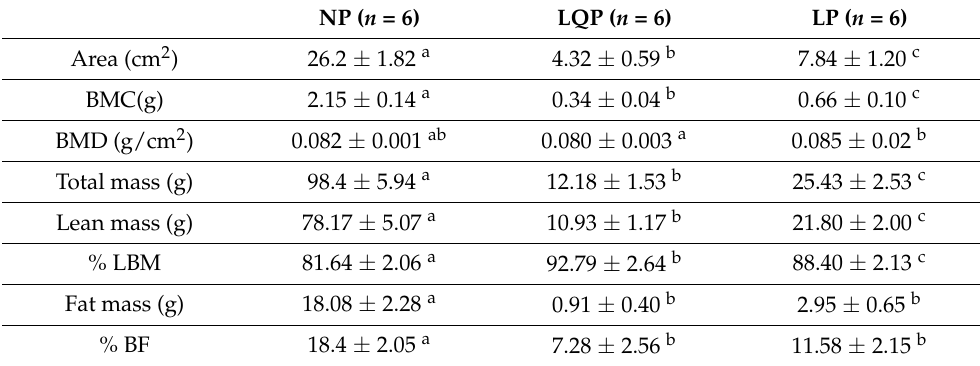
Table 3. Effect of maternal quality and quantity protein restriction on whole-body composition and metabolic factors in the offspring at weaning.